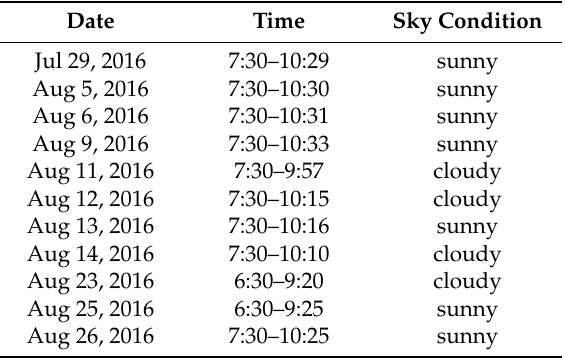
Table 2. List of measurement days, time of measurement and sky